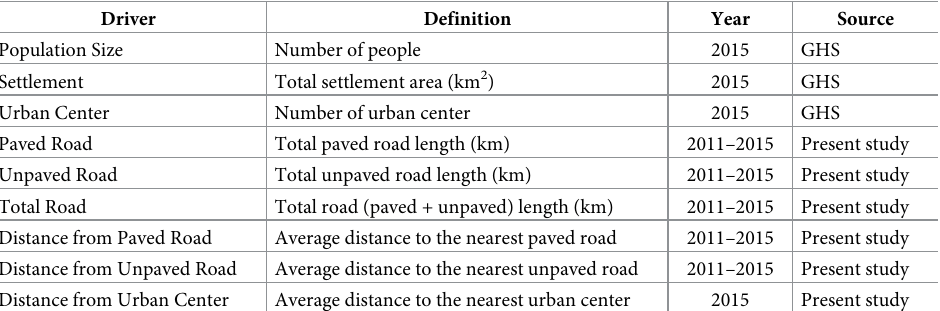
Table 1. Drivers used to analyze mangrove land use due to human pressure by microregion on the Brazilian Ama- zon